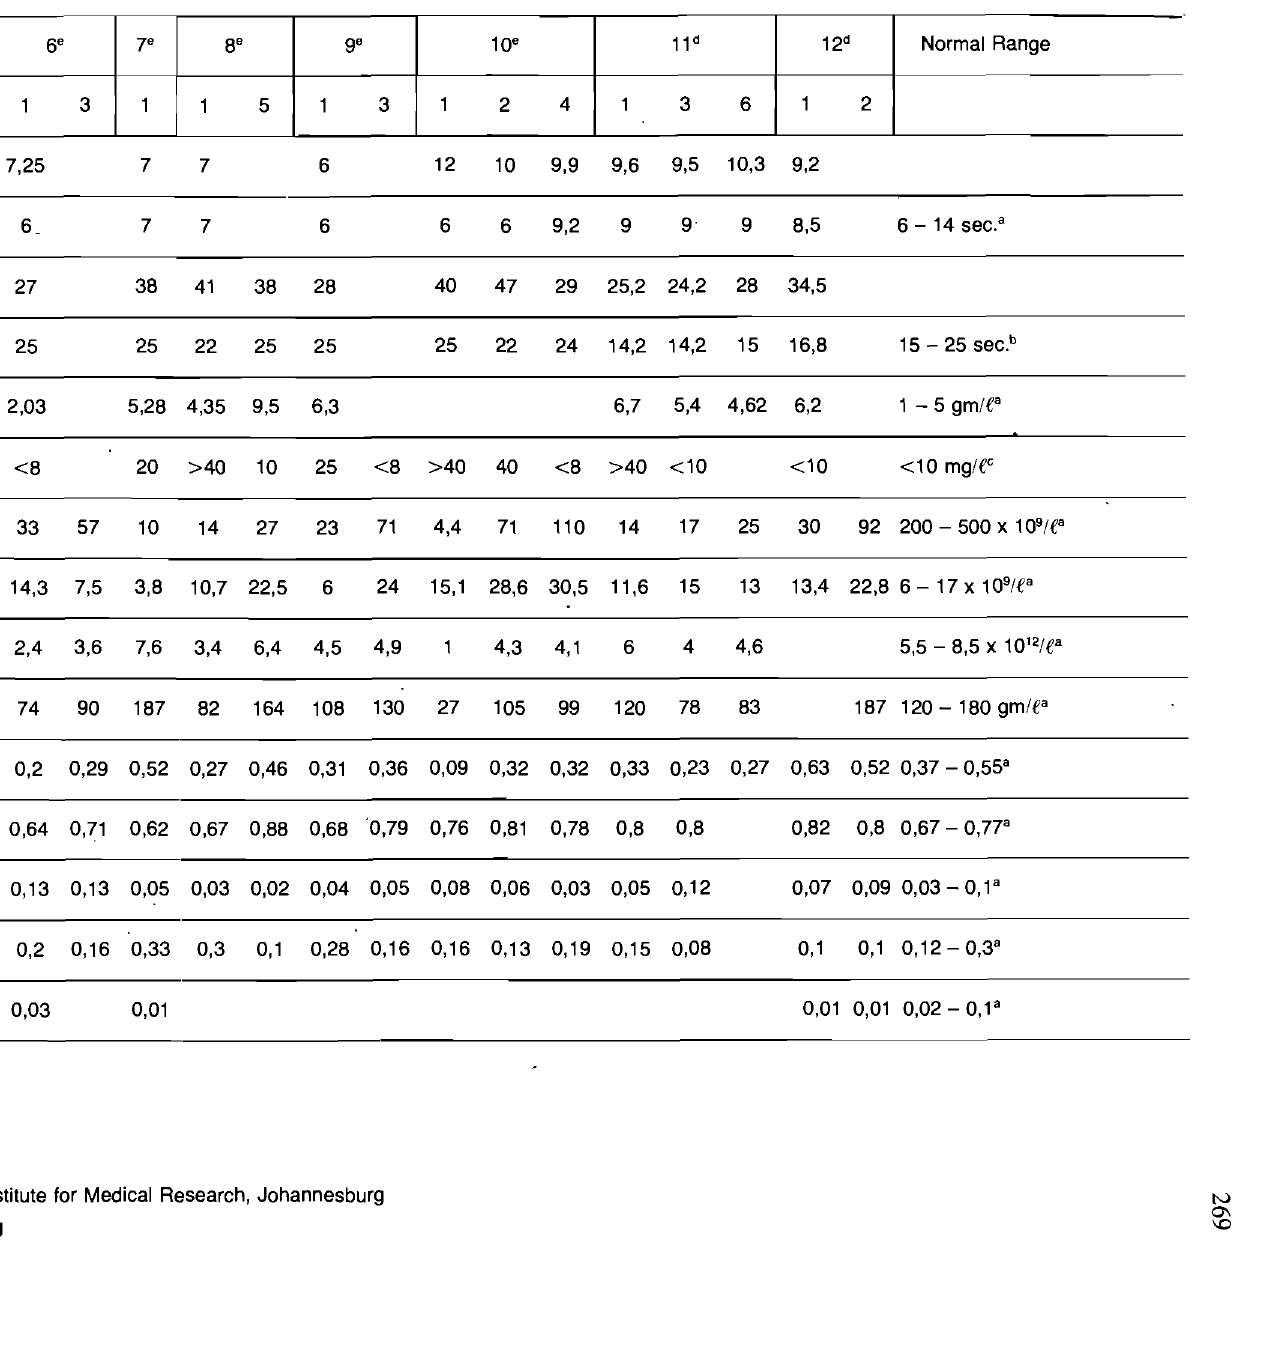
Table 4: HAEMATOLOGICAL AND COAGULATION